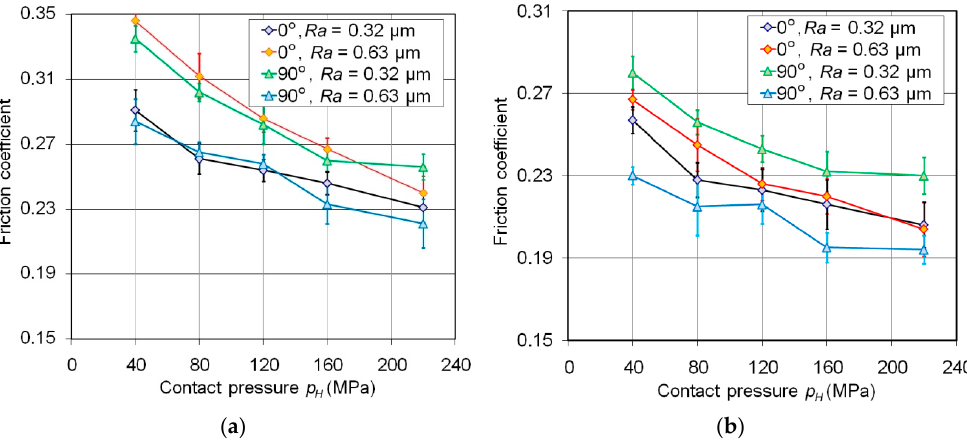
Figure 10. Effect of the contact pressure on the value of the coefficient of friction for ( a ) dry and ( b ) Figure 10. E ff ect of the contact pressure on the value of the coe ffi cient of friction for ( a ) dry and ( b ) lubricated conditions. lubricated